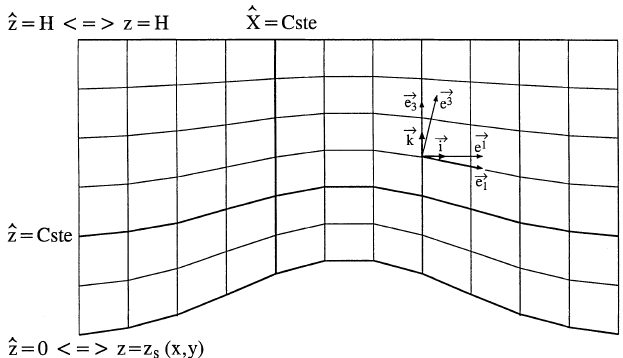
Fig. 2. The Gal-Chen and Sommerville vertical coordinate system and the Cartesian (cid:133) ~ i ;~ k (cid:134) , covariant (cid:133) ~ e i (cid:134) and contravariant (cid:133) ~ e i